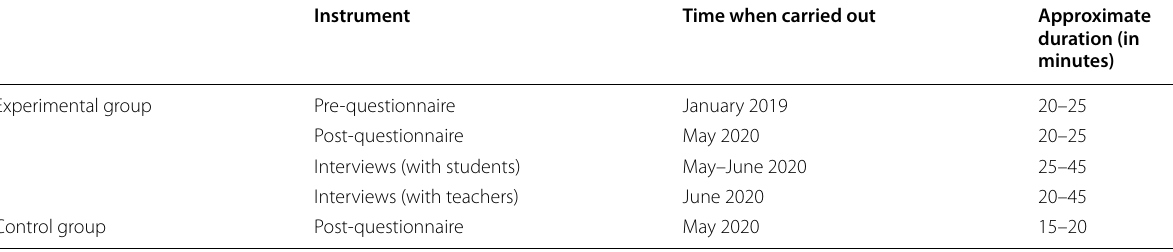
Table 4 Overview of the data collection per instrument used